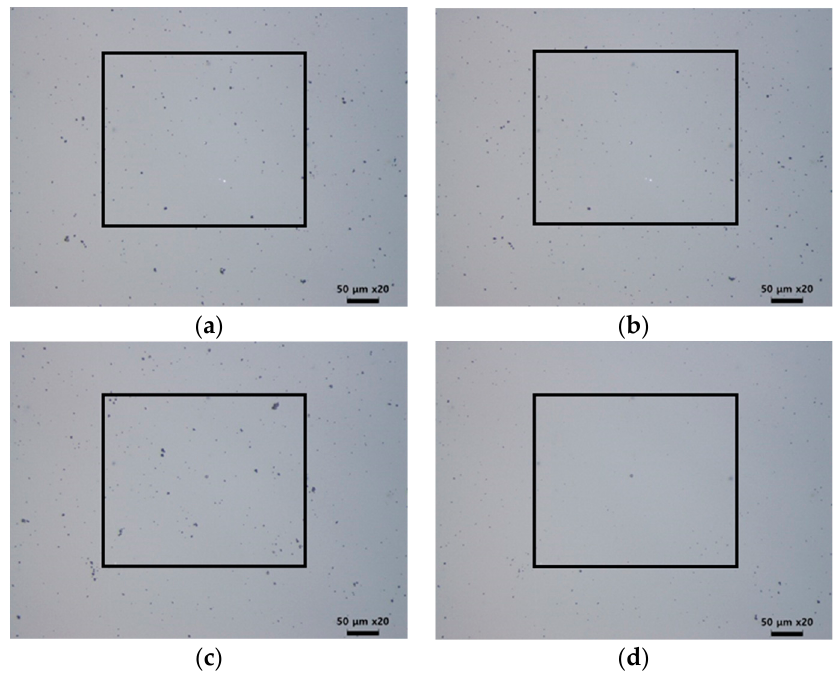
Figure 9 . Result of laser cleaning with different pulse numbers: ( a , c ) is before cleaning, ( b ) pulse number = 30, and ( d ) pulse number = 110.